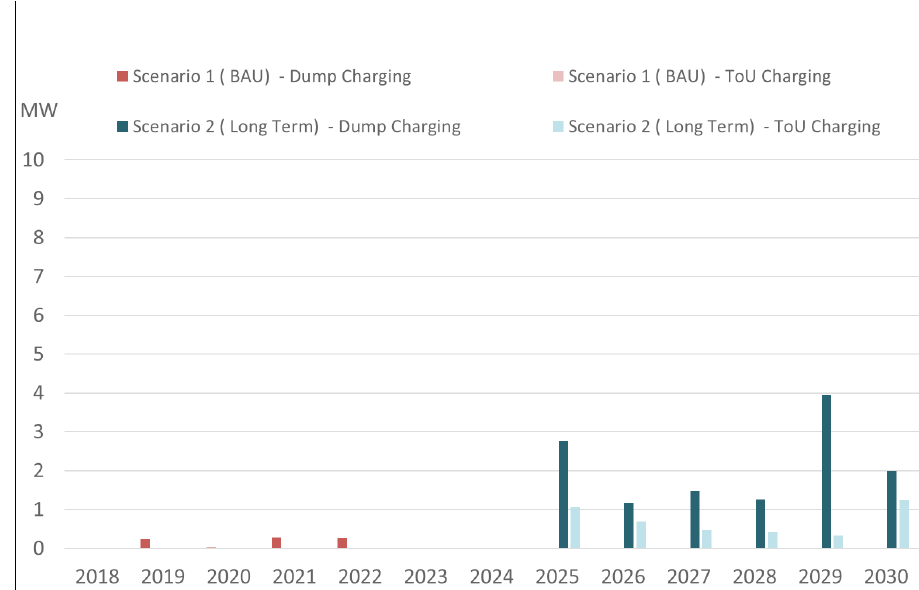
Figure 11: Additional Downward Regulating Reserve requirement of different scenarios.